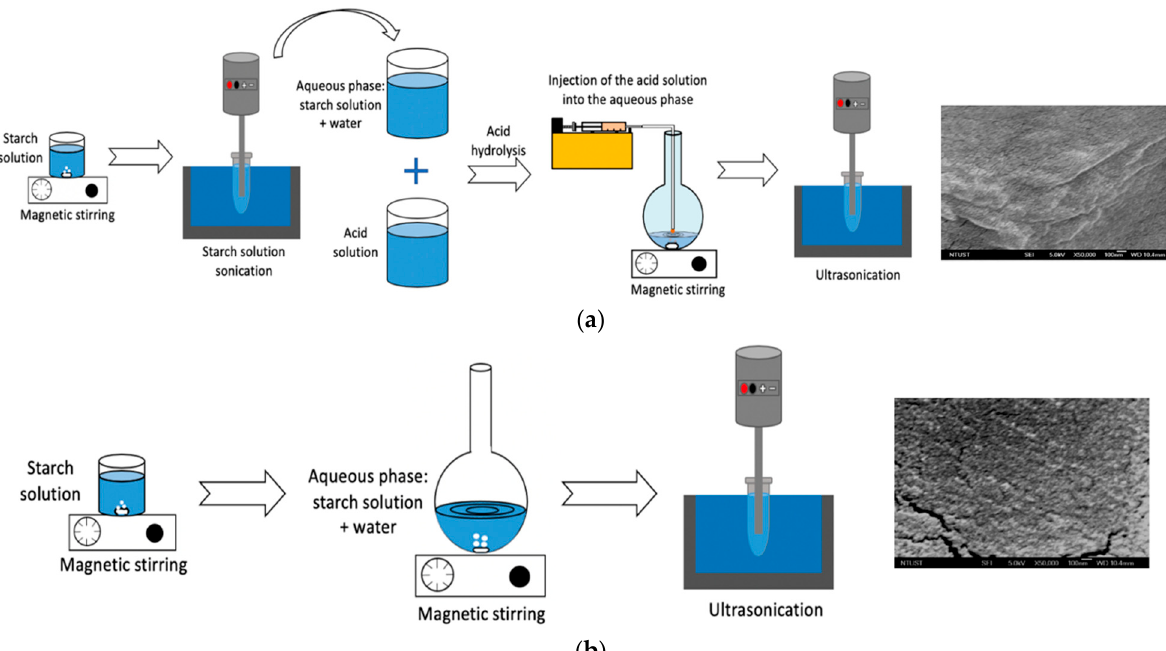
Figure 8. Synthesis of SNPs through ultrasound method: ( a ) with acid hydrolysis; ( b ) without acid hydrolysis and SEM micrograph of corn and potato SNPs [64].